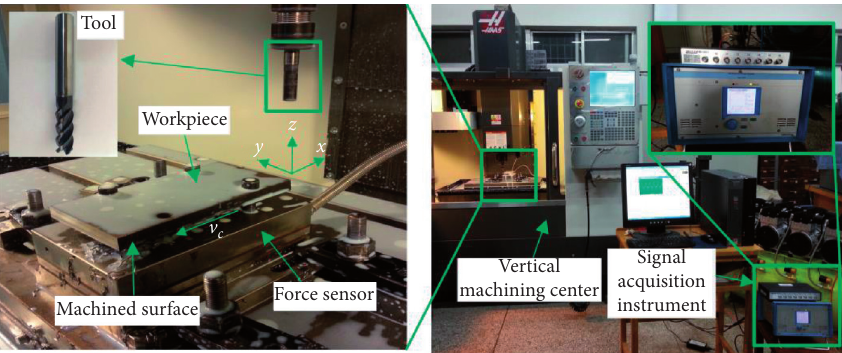
Figure 1: Experimental equipment and measuring equipment.